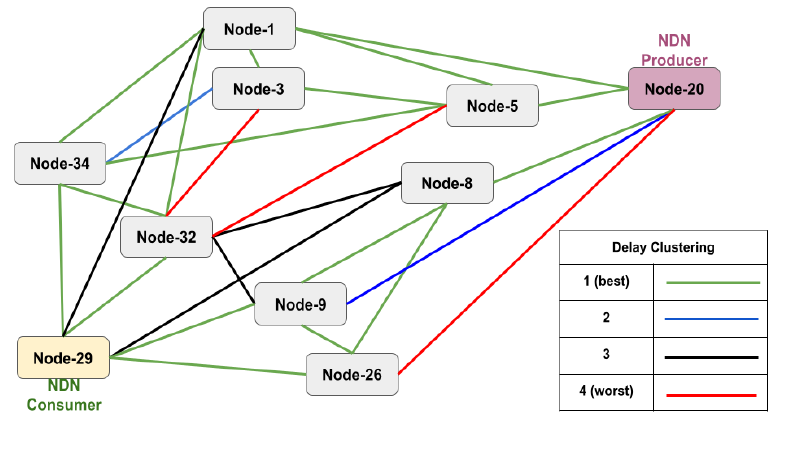
Figure 11. Delay clustering results among network nodes.